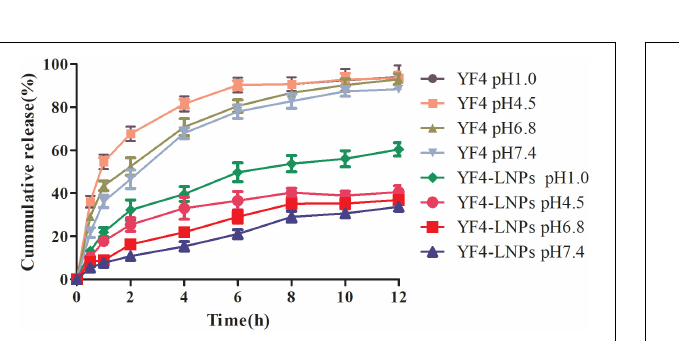
FIGURE 5 | Antihypertensive effects of Free YF4 and Captopril in SHRs within 10 h by a single oral administration of 5